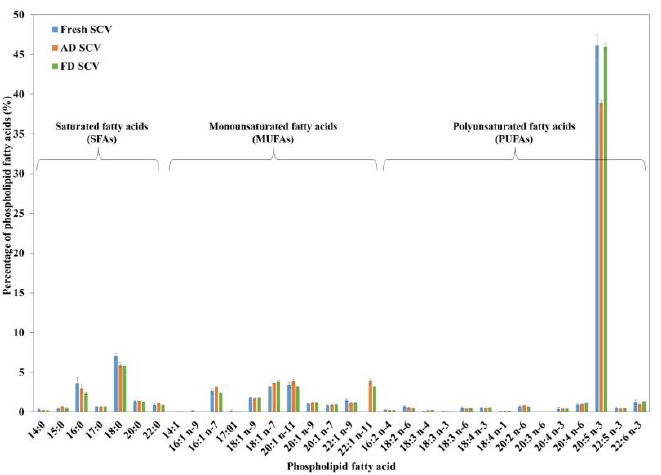
Figure 7. Phospholipid fatty acid composition of fresh, air-dried (AD SCV), and freeze-dried (FD SCV) sea cucumber viscera.